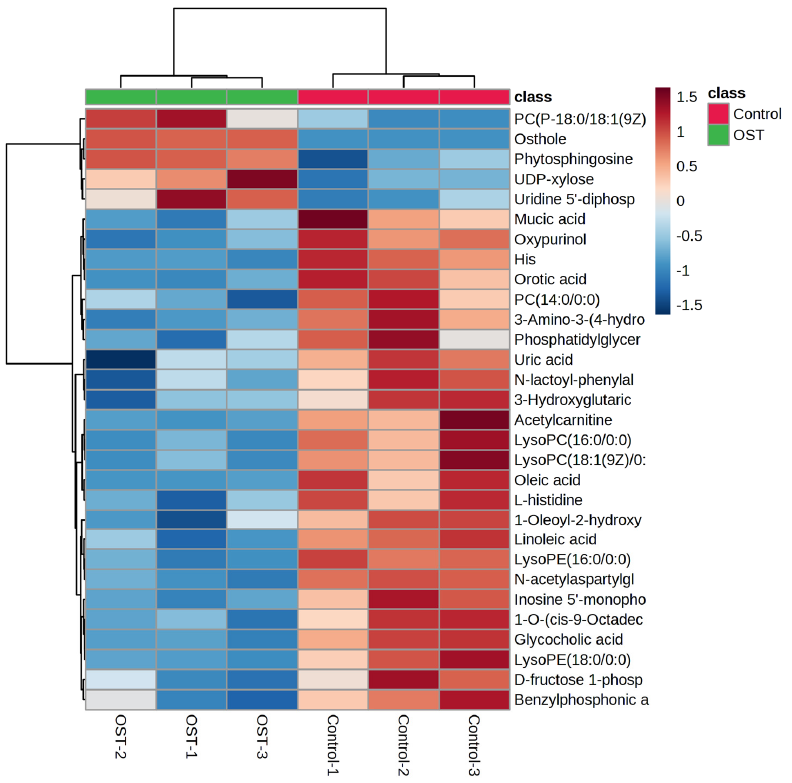
Figure 8. Changes in relative content of potential biomarker 4T1 cells after osthole (OST)